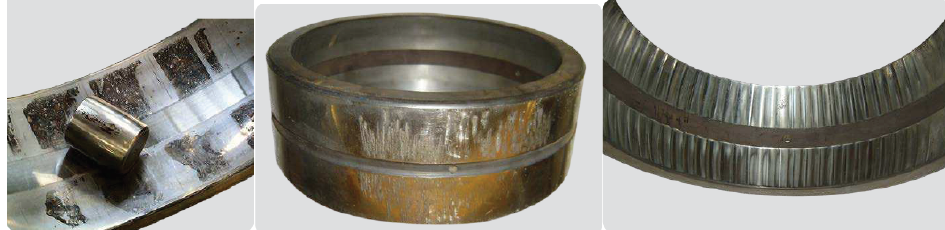
Figure 5. Corrosion failures. Moisture ( left ), fretting ( middle ), and brinelling ( right ) [27]. Courtesy of SKF.